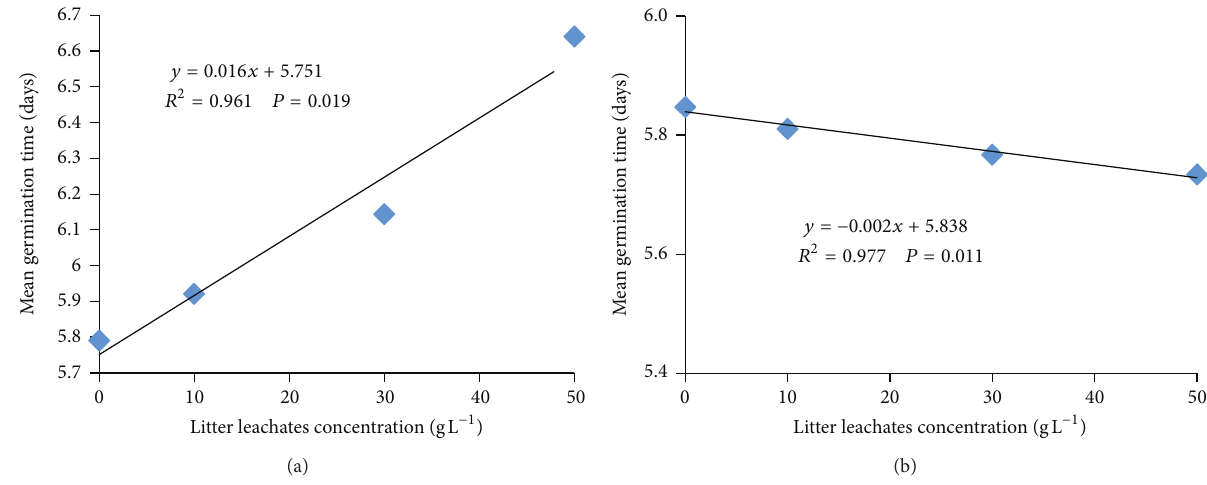
Figure 2: Dose-response relationship curve of the effect of A. compressus litter leachates on mean germination time of A. gangetica (a) and P. polystachion